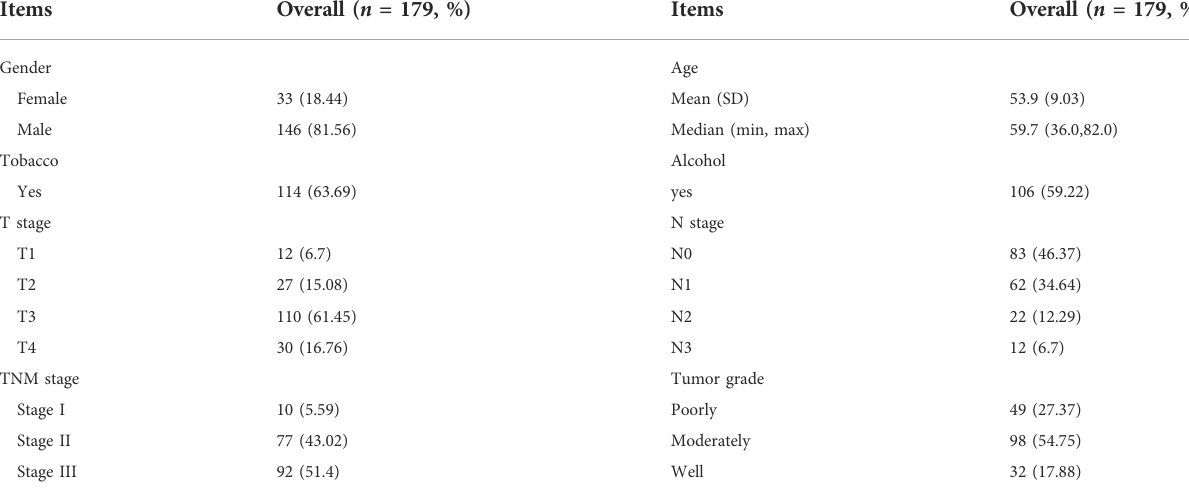
TABLE 2 Clinical characteristics of esophageal squamous cell carcinoma samples in